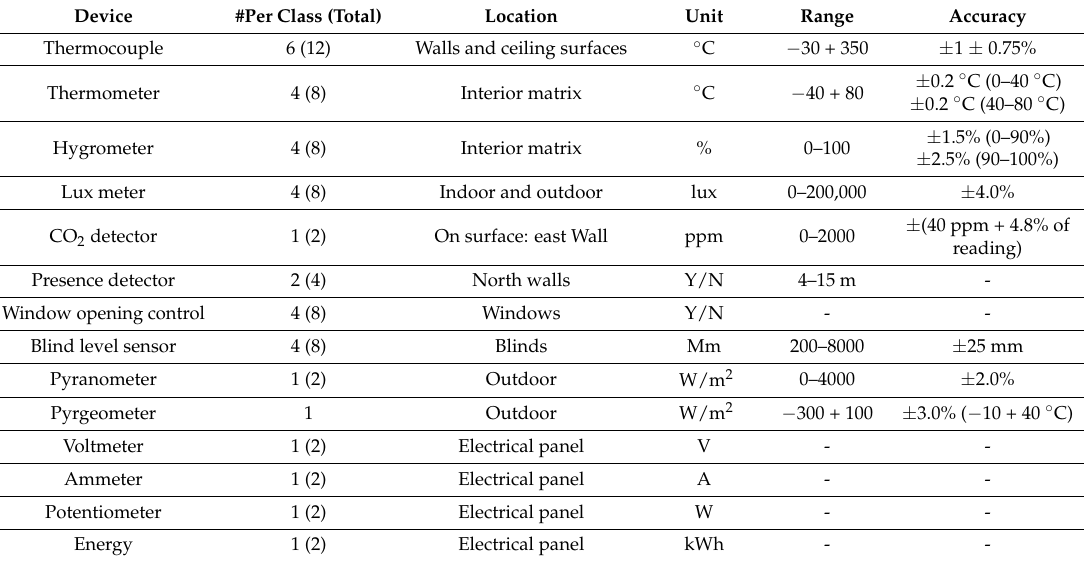
Table 1. Probes in the rooms monitored.